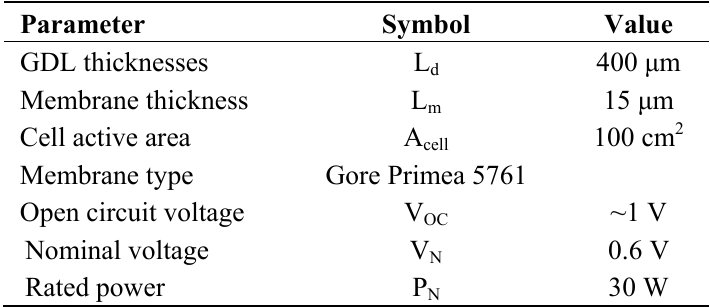
Table 1. Single fuel cell